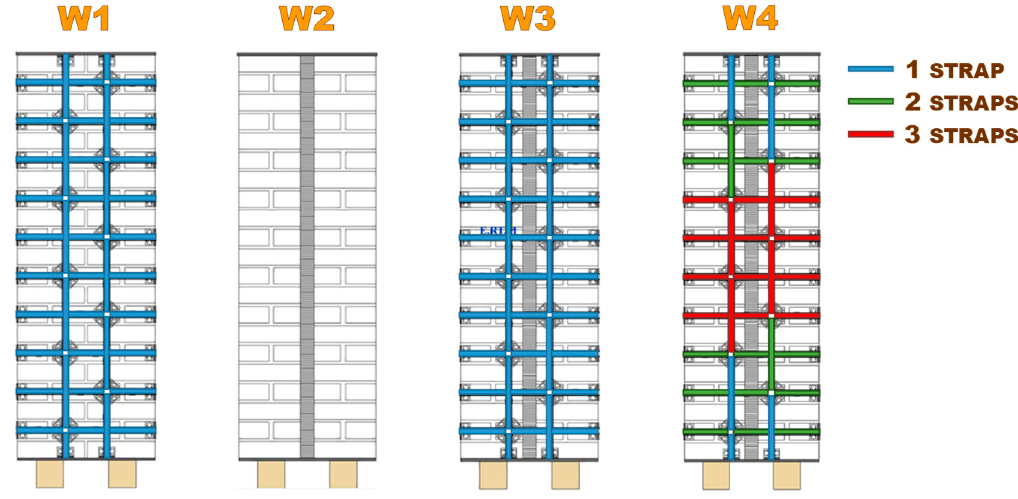
Figure 9. Arrangement of the straps for Specimens W1, W2, W3, and W4.